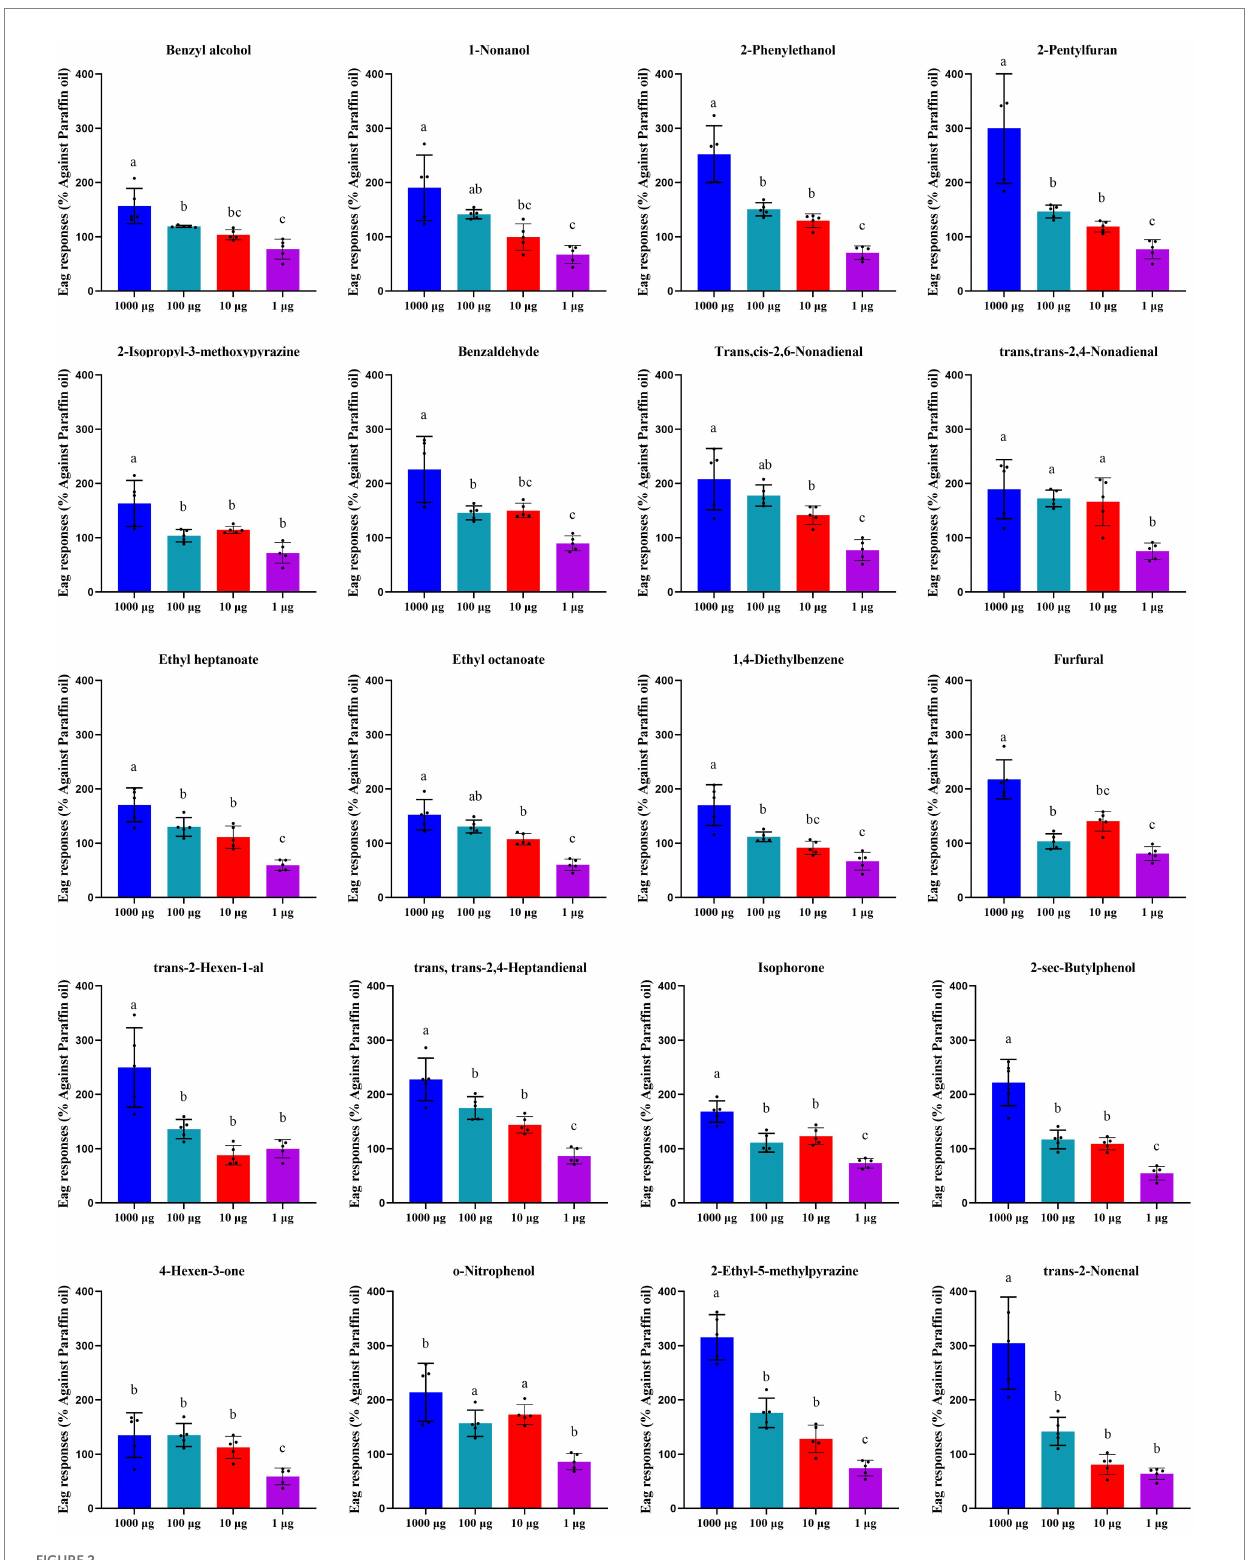
FIGURE 2 Electroantennographic (EAG) responses of T. absoluta females to 20 volatile compounds. The bar represents the standard error, and the different letters above each bar indicate Turkey’s highest significant difference at p <